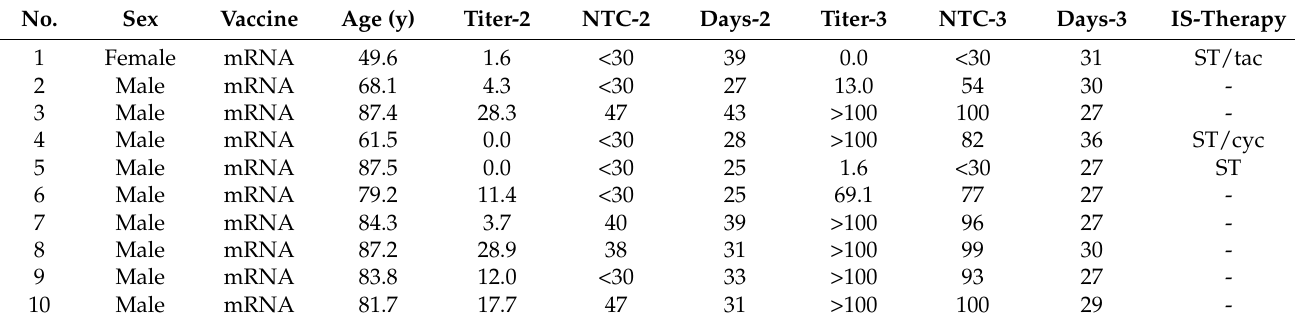
Table 4. Out of 17 individuals with reduced response to standard SARS-CoV-2 vaccination ten patients agreed to receive a third booster vaccination. No local or systemic side effects or signs of myocarditis were noticed after application of the third dosage. Only two patients on immunosuppressive therapy did not mount neutralizing antibodies. SARS-CoV-2 titers in AU/mL, NTC = neutralizing capacity of mounted antibodies in percent, days-2 and days-3 = time from the second and third (booster) vaccination to antibody measurement, ST = steroids, tac = tacrolimus, cyc = cyclophosphamide. No.